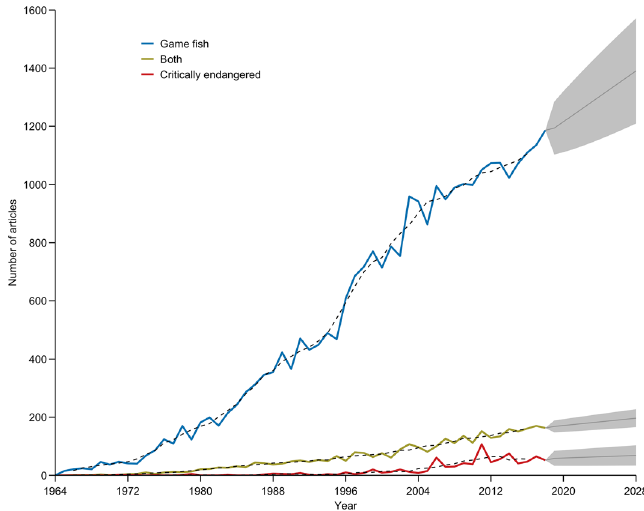
Figure 1. Number of articles published by year for fish species identified as game fish, both, and critically endangered fish. Game fish was defined by International Game Fish Association and listed by Donaldson et al. (2011) and critically endangered was defined by The International Union for Conservation of Nature (IUCN) Red List of Threatened Species. The category both includes species that were classified as game fish and critically endangered. Time series includes the 5-year moving average (dashed black lines) and 10-year forecasted number of articles (grey line) with 95% prediction intervals (grey ribbons). Figure was created using freely available R software (version 4.0.2 & URL: https:// www.r- proje ct.